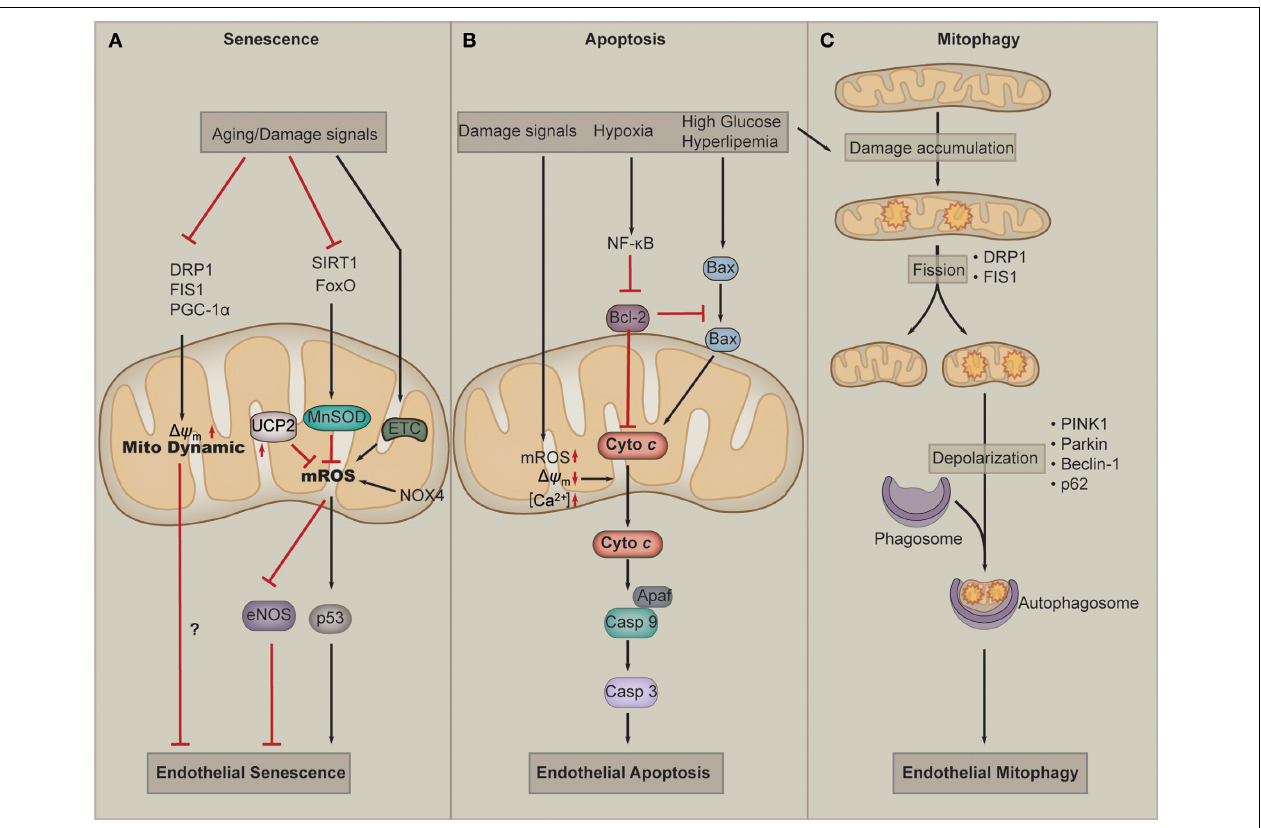
FIGURE 3 | Mitochondria in endothelial cell senescence, apoptosis, and mitophagy. (A) Aging and other damage signals such as hyperglycemia inhibit the activation of dynamic proteins, such as dynamin-related protein-1(Drp1), fission 1(Fis1), and PGC-1 α , which leads to the defects of mitochondria dynamics and endothelial senescence. When exposed to senescent signals, cellular SIRT1 and FoxO are downregulated, which results in downregulation of the antioxidant MnSOD. At the same time, the defected ETC and NOX4 produce more mROS. Those facts leads to accumulation of mROS, which in turn results in eNOS uncoupling and p53 activation, and subsequently endothelial cell senescence. (B) Damage signals lead to a loss of transmembrane potential ( (cid:2) ψ m ), accumulation of mROS and Ca 2 + . These effects of mitochondrial dysfunction contribute to the release of cytochrome c